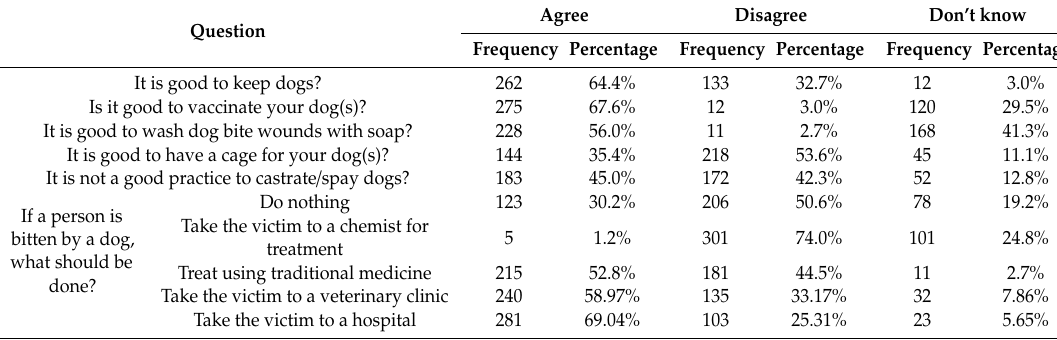
Table 4. Practices of study